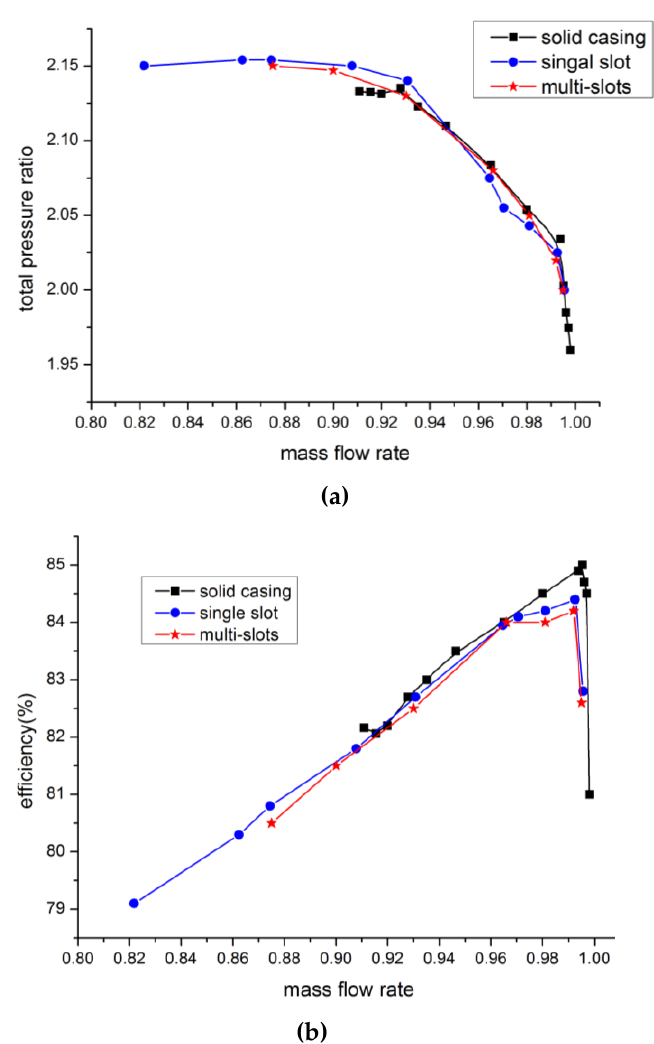
Figure 18. Characteristic curve for the solid wall casing and axial slots of different circumferential intervals. ( a ) Total pressure ratio characteristic curves; ( b ) efficiency characteristic curves.